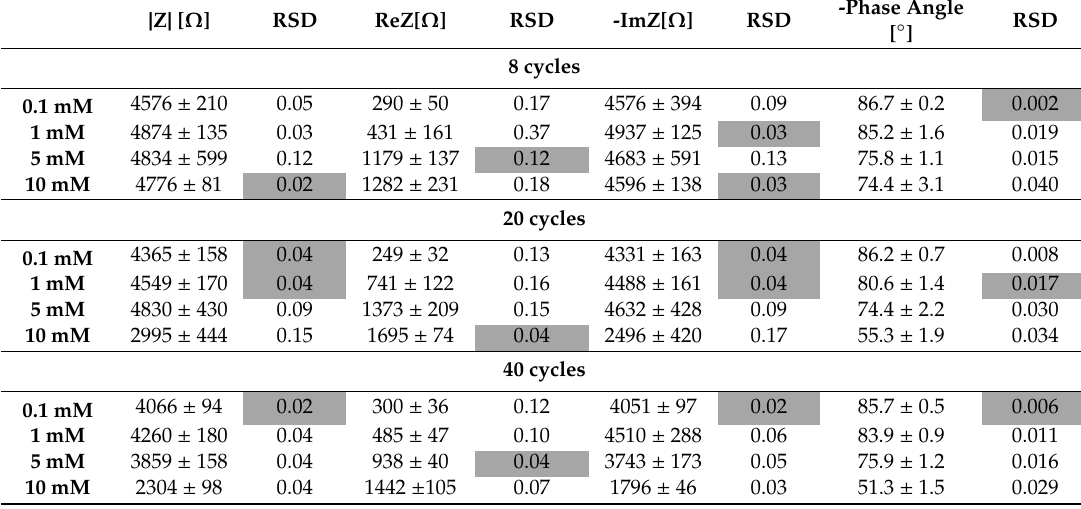
—the lowest value of Table A2. Table of mean values of phase angle and |Z| recorded in the lowest frequency (0.1 Hz), resistance ReZ and –ImZ with SD and RSD measured for annealed TNT arrays after deposition of